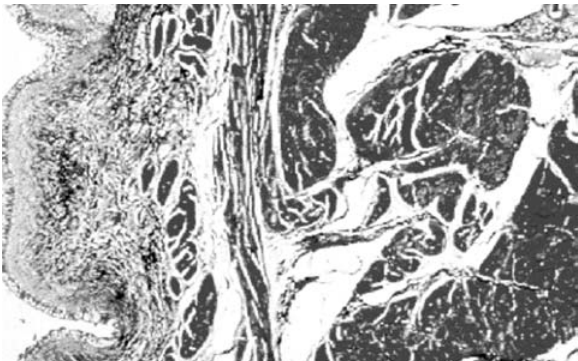
Figure 1 – Photomicrograph of SIS implanted in dog bladder as an augmentation cystoplasty. Masson’s trichrome stain, 13 months after implantation. (Photomicrograph kindly provided by Dr. Steven